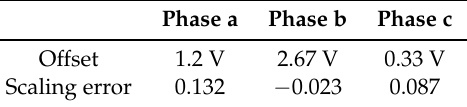
Table 1. Errors in grid-voltage measurement.